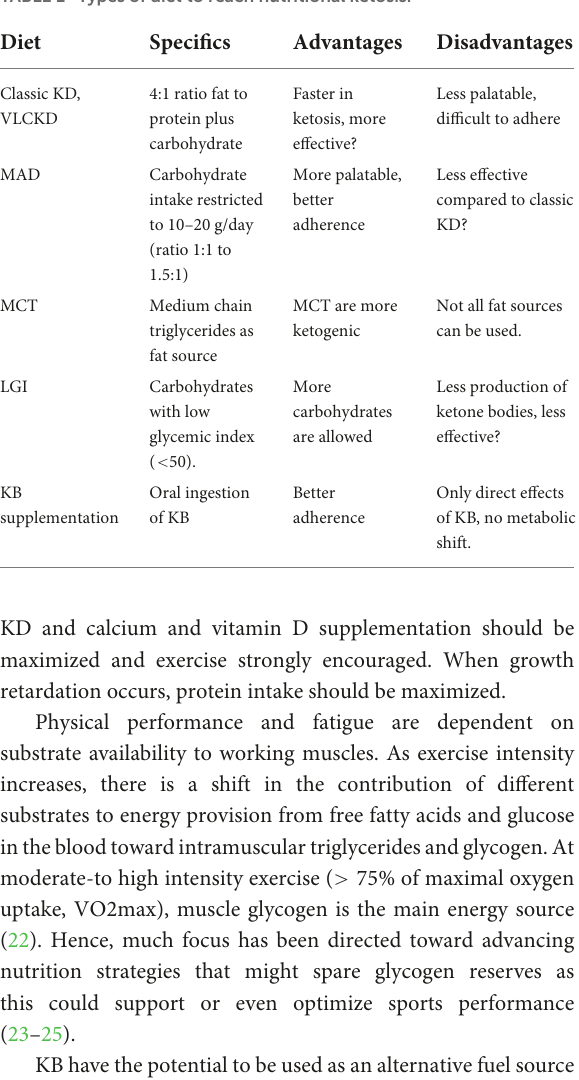
TABLE 1 Types of diet to reach nutritional